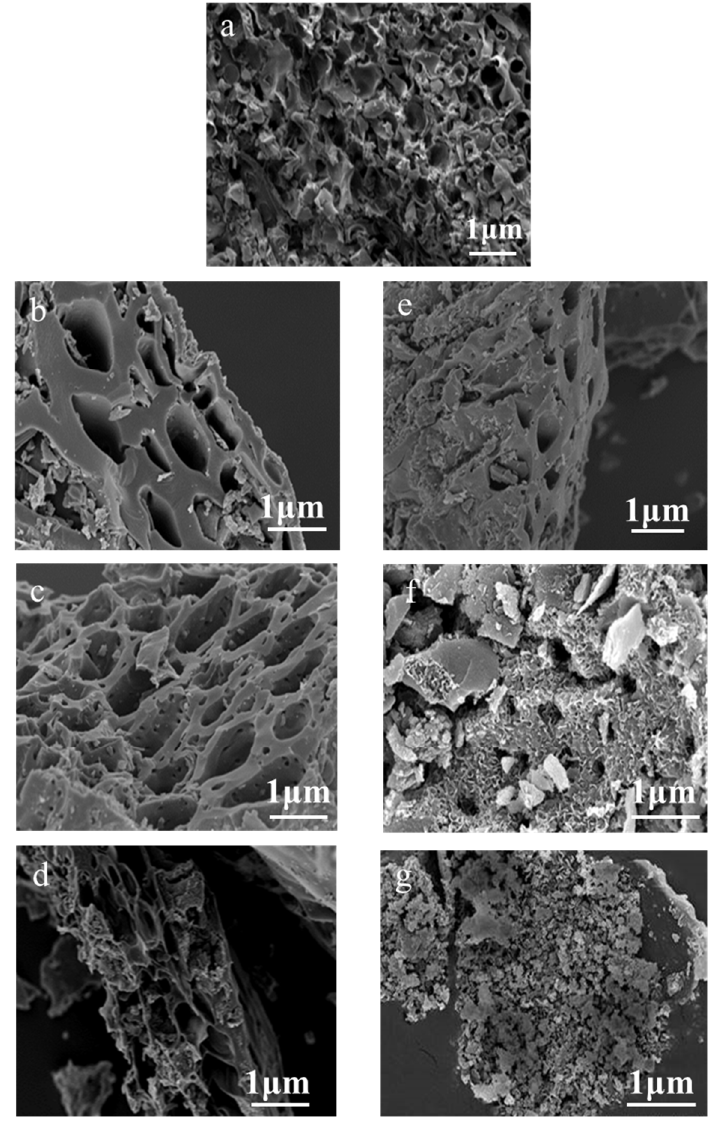
Figure 2. SEM images of: ( a ) RH, ( b ) RH-800, ( c ) RH-900, ( d ) RH-1000, ( e ) Act-RH-800, ( f ) Act-RH-900, and ( g ) Act-RH-1000.